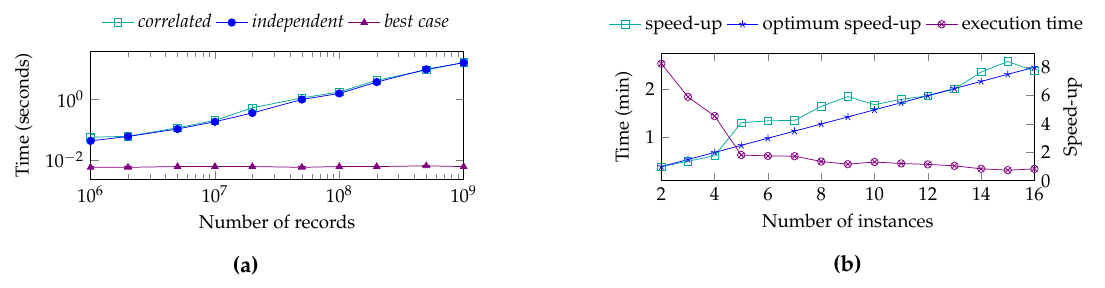
Figure 13. Performance evaluations for the on-demand computation model using Elasticsearch. ( a ) Upper bound for all on-demand queries, corresponding to computing the total initial view for varying dataset types and number of records; ( b ) Scalability of on-demand queries, tested on cluster-selection queries for an independent dataset with 2 × 10 8 records. The speedup is relative to using two